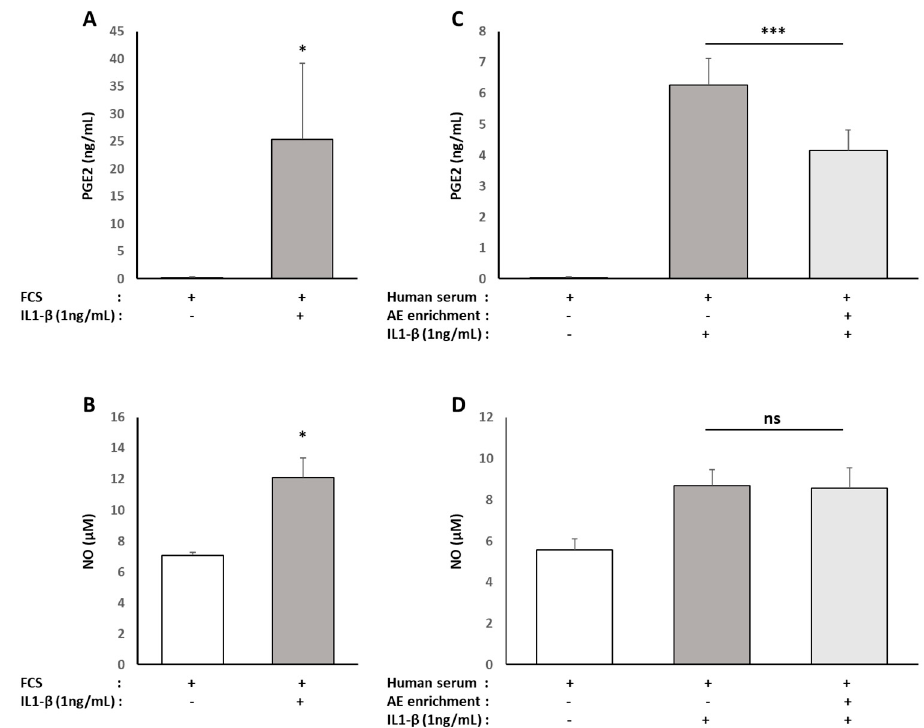
Figure 11. Effect of human serum enriched with ALE metabolites on inflammatory mediator pro- duction of NO and PGE2 in primary human articular chondrocytes: Human articular chondrocytes (HACs) were harvested from the tibial plateau and femoral condyles following knee replacement surgery and isolated. HACs were preincubated with fetal calf serum for 24 h and stimulated with IL-1 β (1 ng/mL) for an additional 24 h ( A , B ). To analyze the effects of human serum enriched with metabolites, cells were preincubated for 24 h in DMEM in the presence of 10% of human enriched serum according to the Clinic’n’Cell protocol (DIRV INRA 18-00058) prior to an additional 24 h treatment with human recombinant IL-1 β (Millipore Corporation, Molsheim, France) at 1 ng/mL ( C , D ). NO ( B , D ) and PGE2 ( A , C ) releases in culture media were measured. IL-1 β stimulated NO and PGE2 releases independently of the origin of the serum (calf or human). The human serum enriched with OPCO metabolites significantly limited PGE2 release but had no observable effect on NO release. * ( p < 0.05); *** ( p < 0.001); ns : no significant difference.